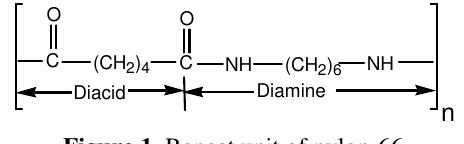
Figure 1. Repeat unit of